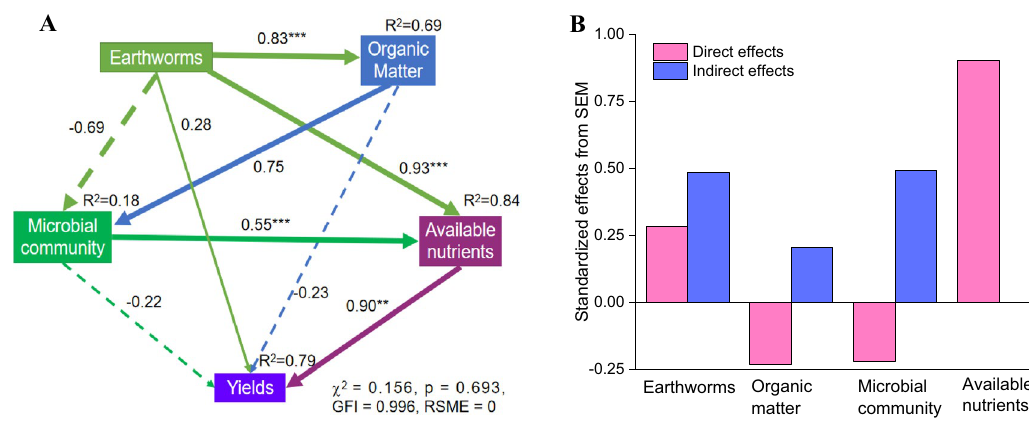
Figure 8. The structural equation model (SEM) between environmental factors and lily yield ( A ), and the direct and indirect effects of environmental variables on lily yield ( B ). The width of the arrows in ( A ) indicates the strength of the standardized path coefficient. The solid lines indicate positive path coefficients and dashed lines indicate negative path coefficients, R 2 values represent the proportion of the variance explained for each endogenous variable. Available nutrients were represented by the first component from a principal-component analysis (PCA) conducted with available nitrogen (AN), available phosphorus (AP), and available